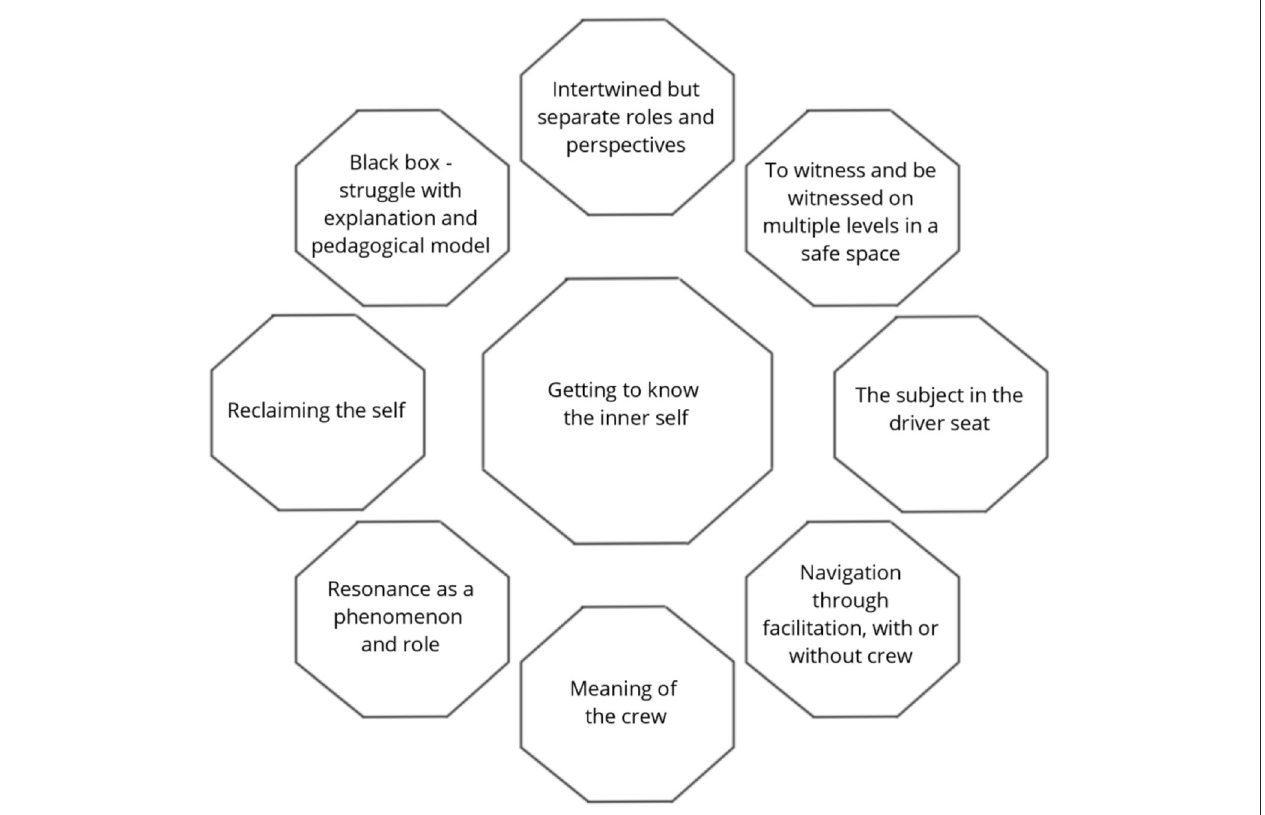
FIGURE 2 | Study findings showing a process of change “Getting to know the inner self” and categories contributing to the named process of self-discovery and inner